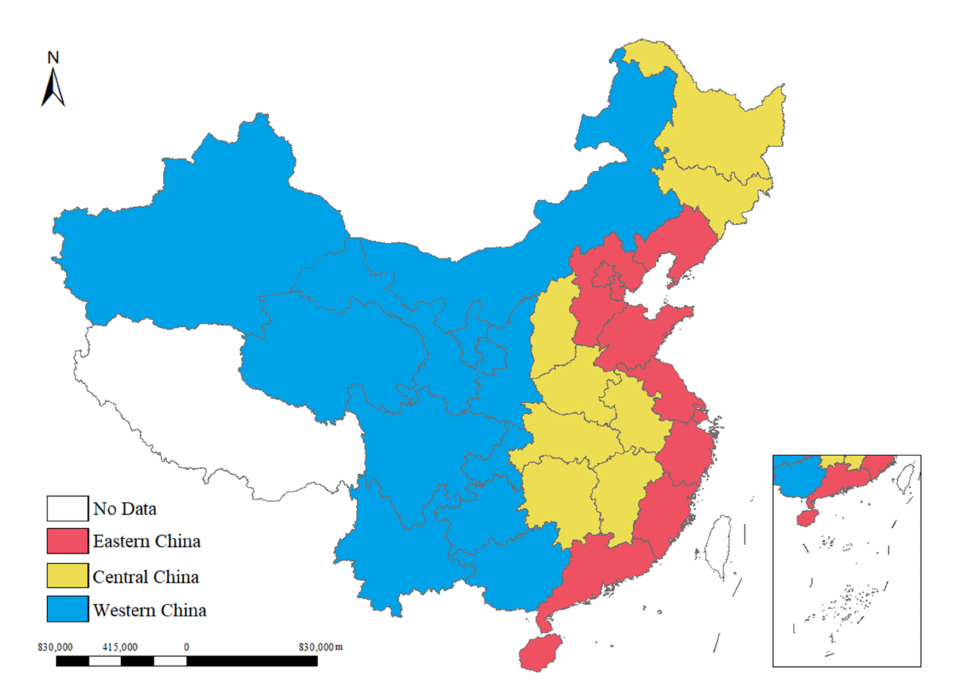
Figure A1. Three major regions: eastern China, central China, and western